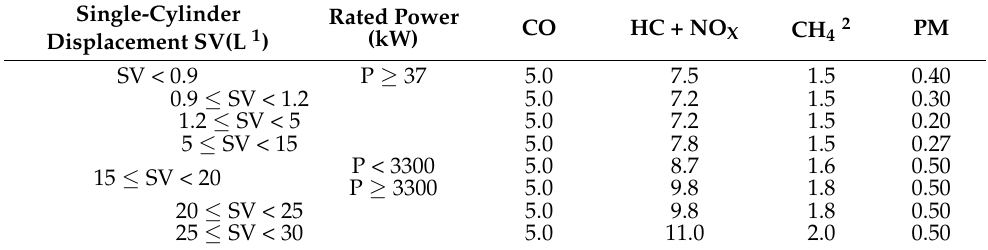
Table 2. CHINA I emission limit (g/kWh). Single-Cylinder